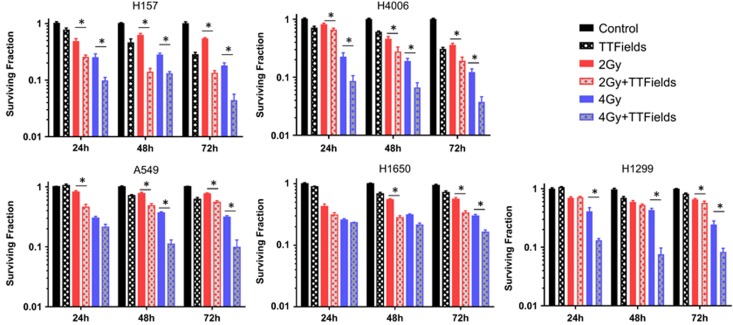
TTFields sensitize NSCLC cells to IR. TTFields treatment was applied alone or immediately following treatment with 2 or 4 Gy of 137Cs γ-rays. Survival was then assessed in all cell lines following 24, 48 or 72 h of TTFields induction. Error bars represent the S.E.M. of three separate experiments and asterisks represent values where survival was significantly decreased (P<0.05; Table 2)